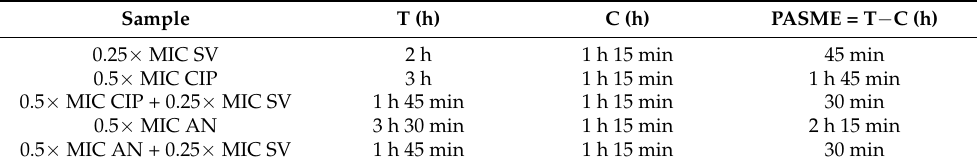
Figure 7. PASME of amikacin (AN) against E. coli in the presence of S. virgaurea extract (SV). Table 3. PASME of ciprofloxacin (CIP) and amikacin (AN) against E. coli in the presence S. virgaurea extract (SV).